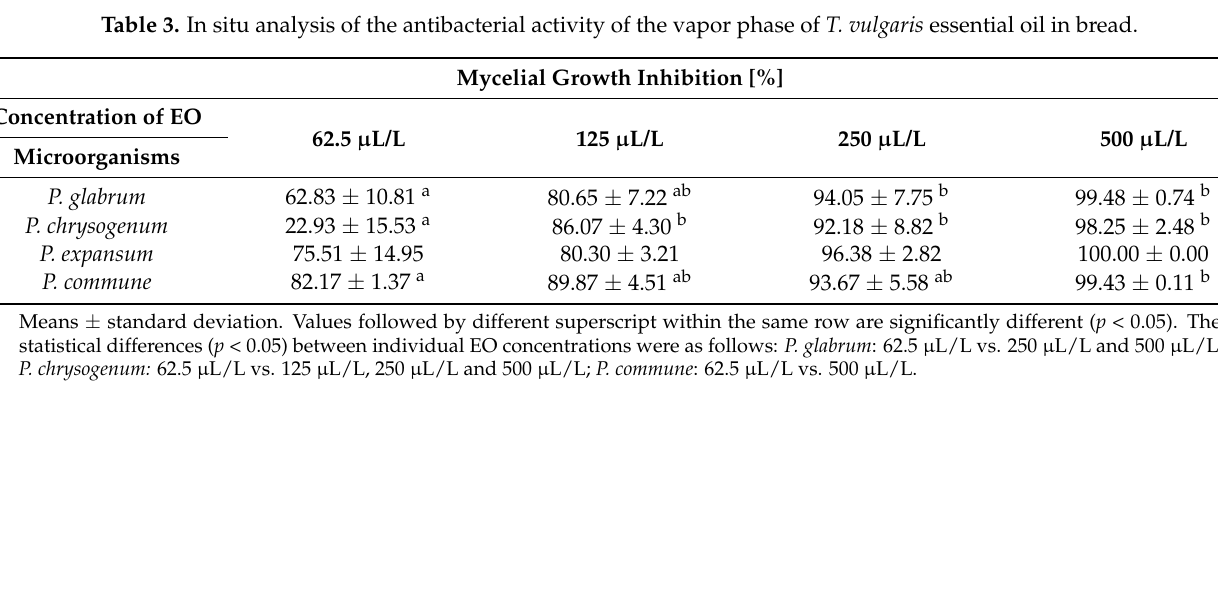
Table 3. In situ analysis of the antibacterial activity of the vapor phase of T. vulgaris essential oil in bread. Mycelial Growth Inhibition [%]